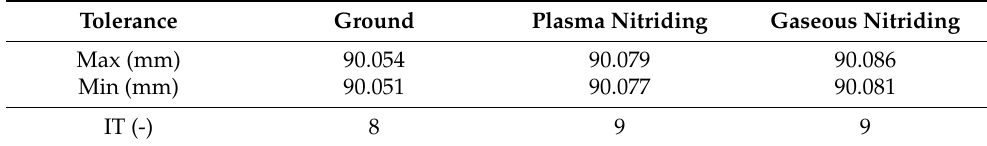
Table 3. Tolerance of sample dimensions and degree of